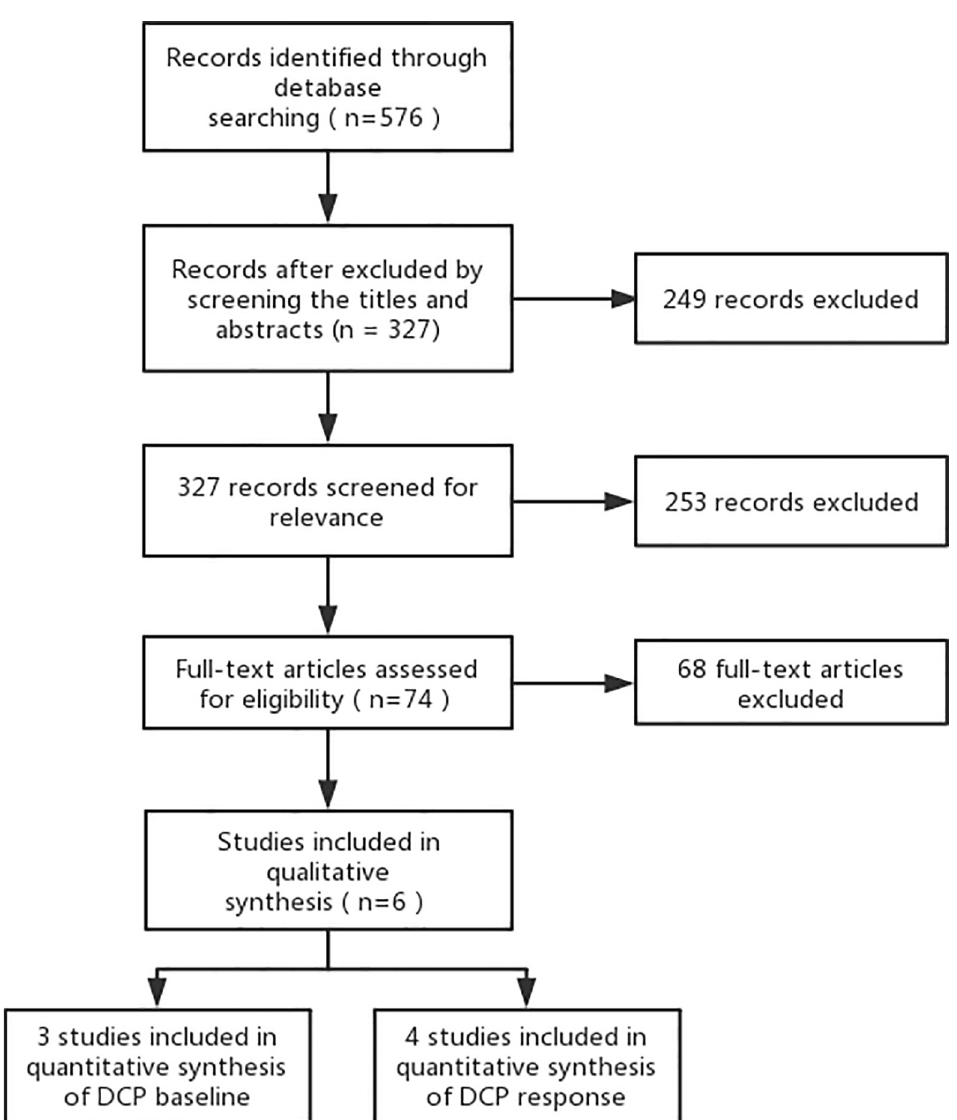
Fig 1. PRISMA flow chart represents the flow of information through the different phases of the systematic